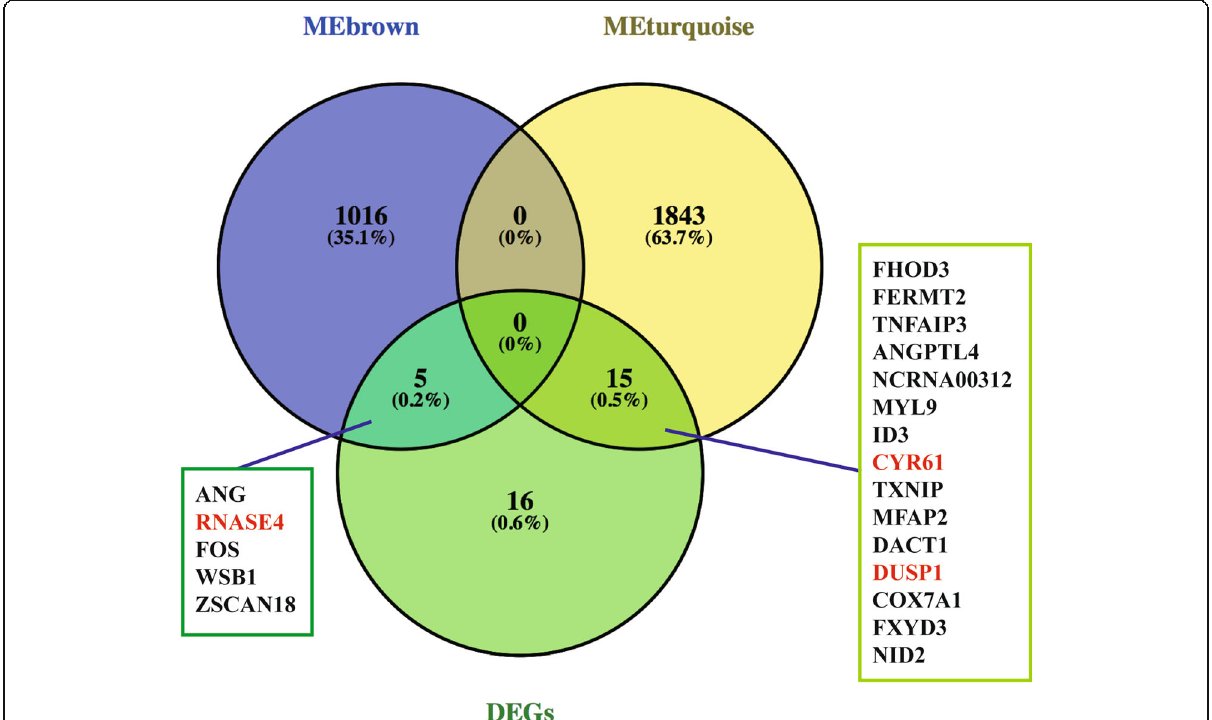
Fig. 5 A Venn diagram showing the overlapping genes between modules and DEGs. Genes marked in red met the screening criteria and were chosen as the final set of candidate